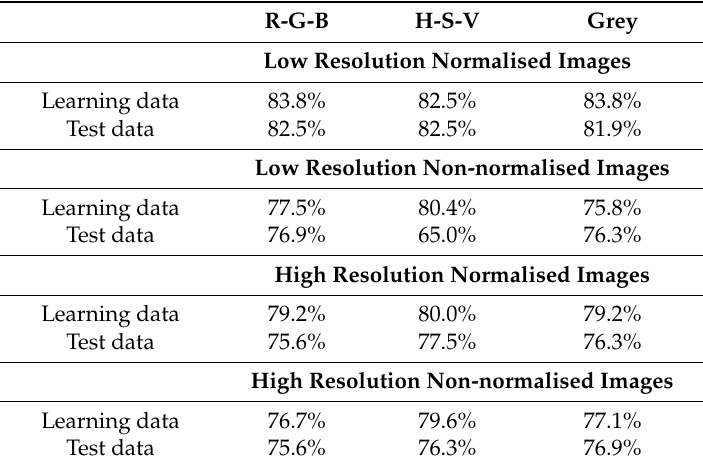
Table 4. The accuracy of separation by means of Bayes